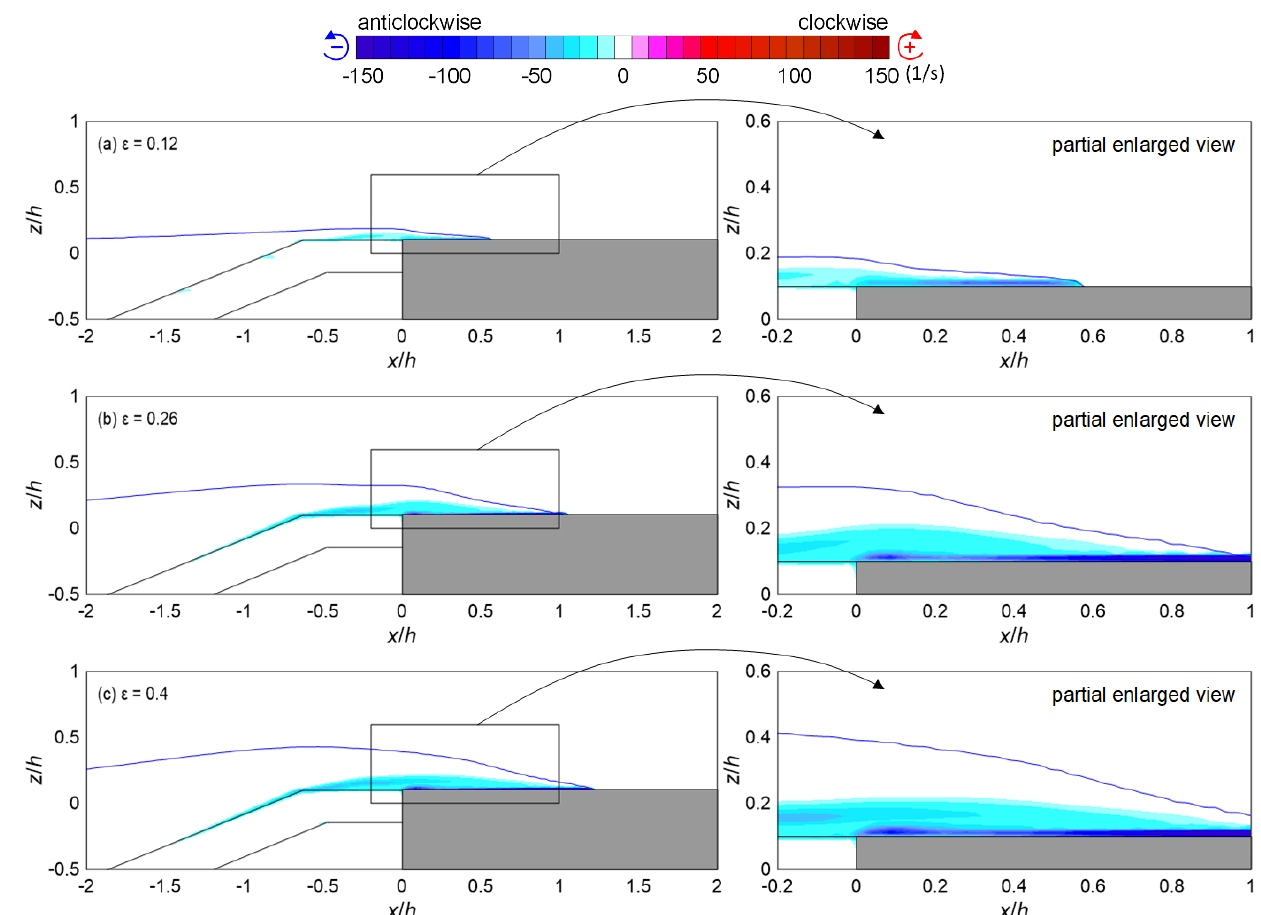
Figure 23. Wave and vortex fields around the WAR when the maximum water level occurs at the front of the vertical wall ( 𝑥/ℎ = 0 ).